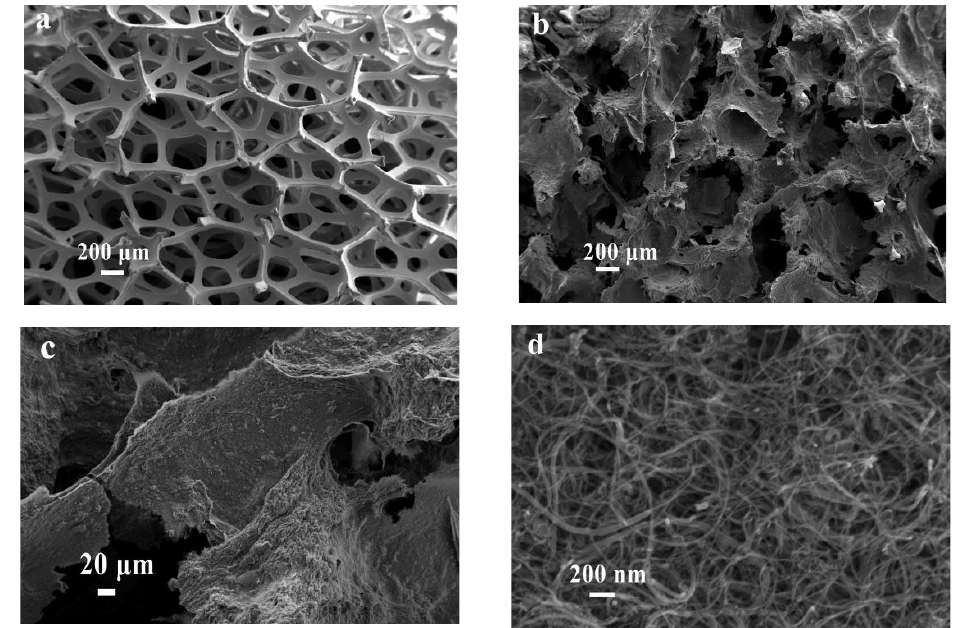
Figure 3. SEM images of ( a ) NF electrodes; SEM images of ( b – d ) B1